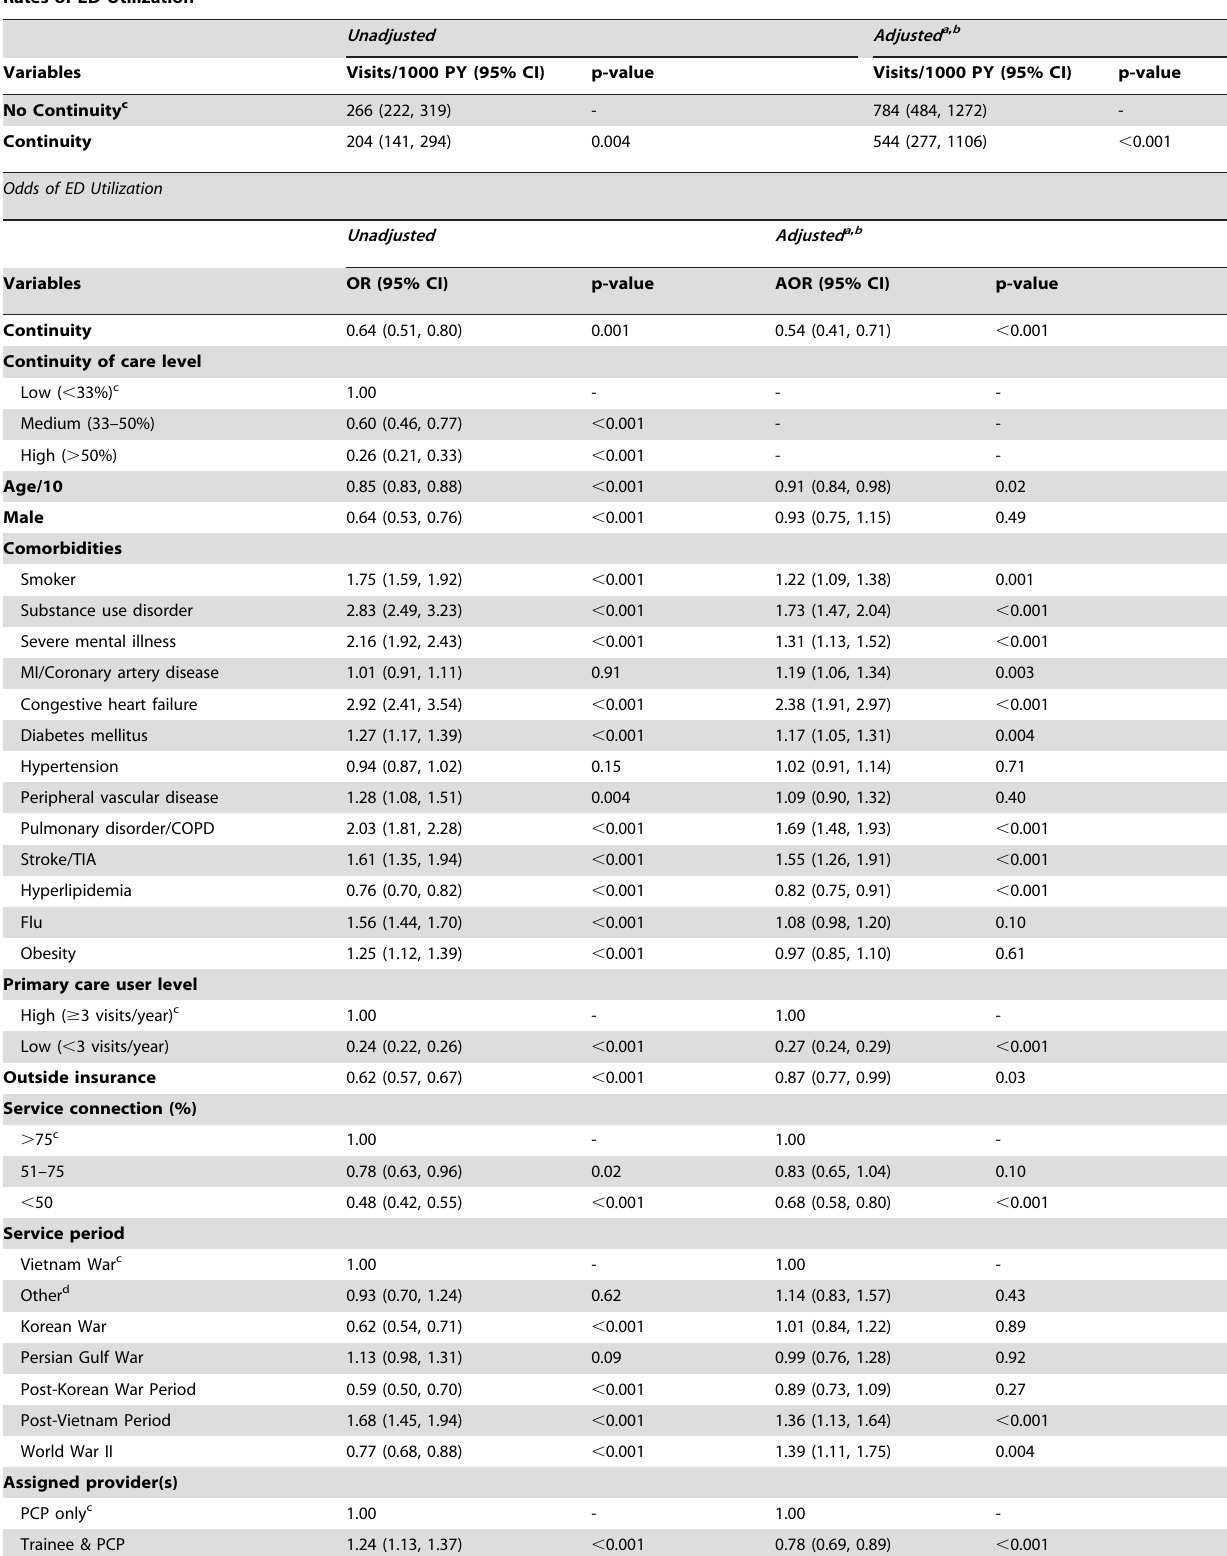
Table 3. Association Between Continuity of Care and Emergency Department